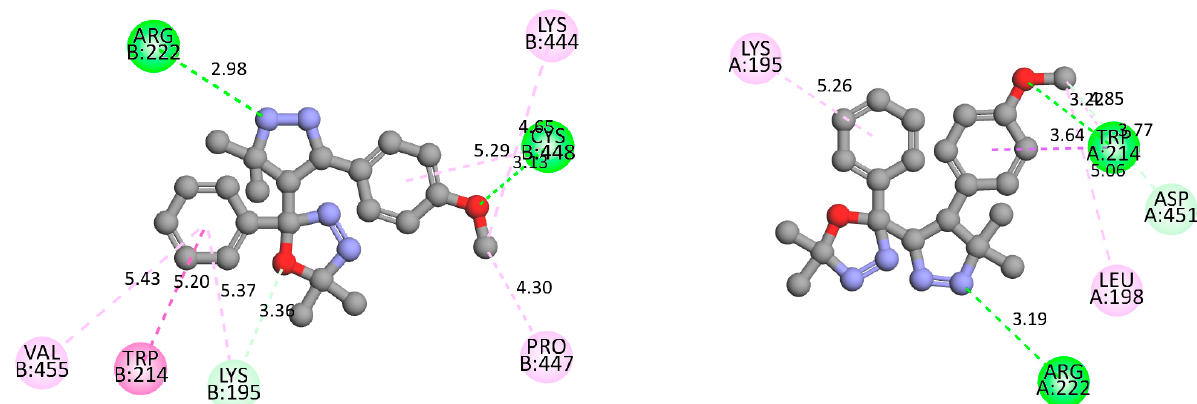
Figure 7. 2D depiction of docking of ligands 1HP14 and 1HP24 in the active site of Human Serum Albumin.